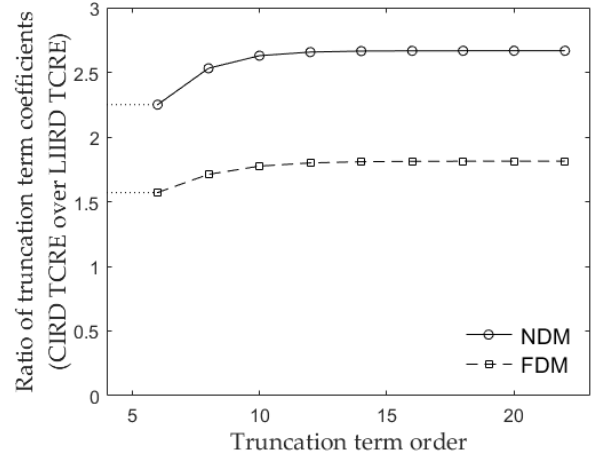
Figure 4. Ratios of truncation term coefficients for term orders 6 to 22 (CIRD TCRE over LIIRD TCRE) based on the negligible dimensions model (NDM) and the FDM respectively.